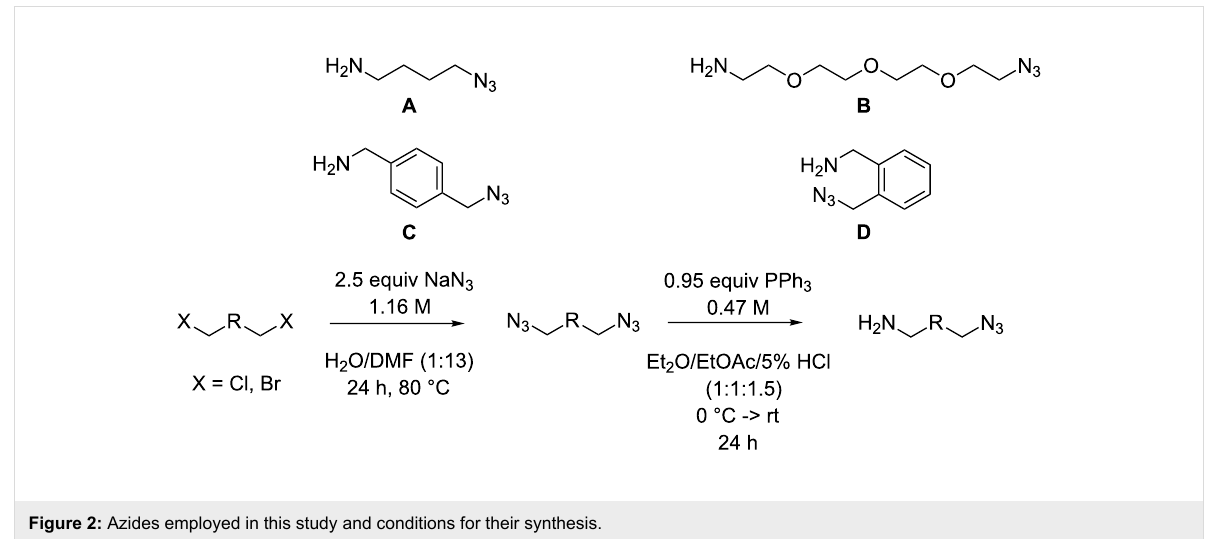
Figure 2: Azides employed in this study and conditions for their synthesis.